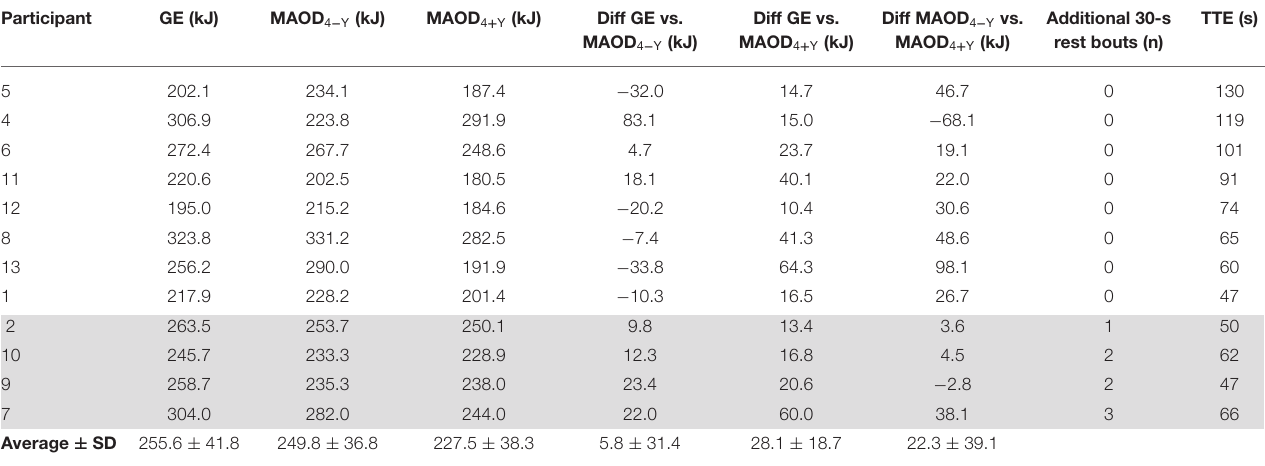
TABLE 1 | Individual anaerobic work in metabolic terms while including the final sprint till exhaustion and excluding G7, determined using the gross efficiency (GE) method and maximal accumulated oxygen deficit (MAOD) method.